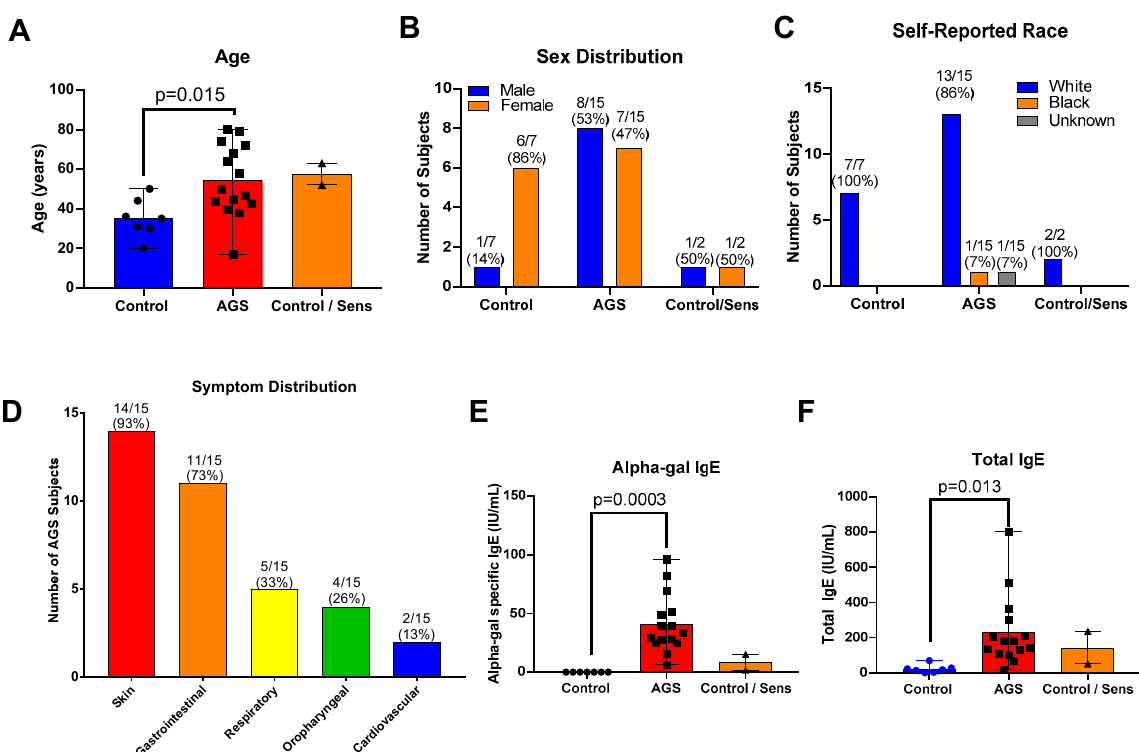
Figure 1. Study participant characteristics for multiplex gene expression analysis cohort. ( A ) Age. ( B ) Sex. ( C ) Self-reported race. ( D ) Symptom distribution. ( E ) Serum alpha-gal-specific IgE. (F) Serum total IgE. Control ( n = 7); sensitized but asymptomatic (“Control/Sens,” n = 2); Alpha-gal syndrome (“AGS”; n = 15). p values were generated using an unpaired t test comparing AGS to control, with p < 0.05 considered significant. Due to the small sample size, the sensitized but asymptomatic group was excluded from the statistical analysis .